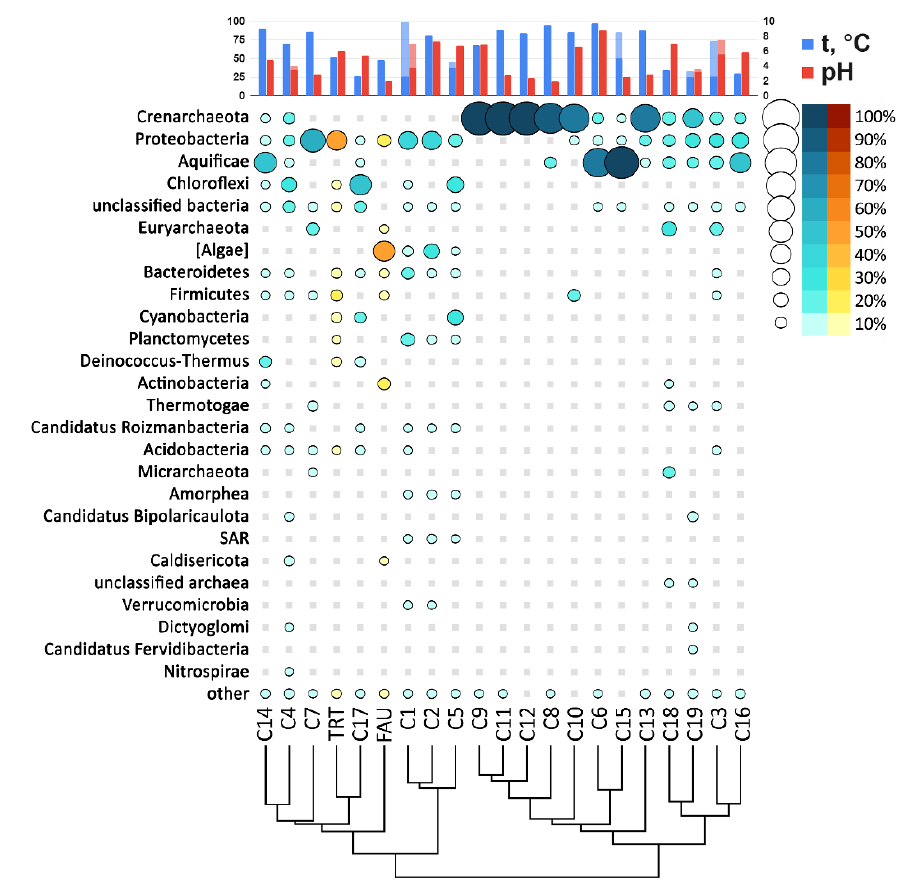
Figure 9. The abundance bubble chart of microbial phyla in the FAU, TRT (yellow), and C01–C19 (blue) communities.